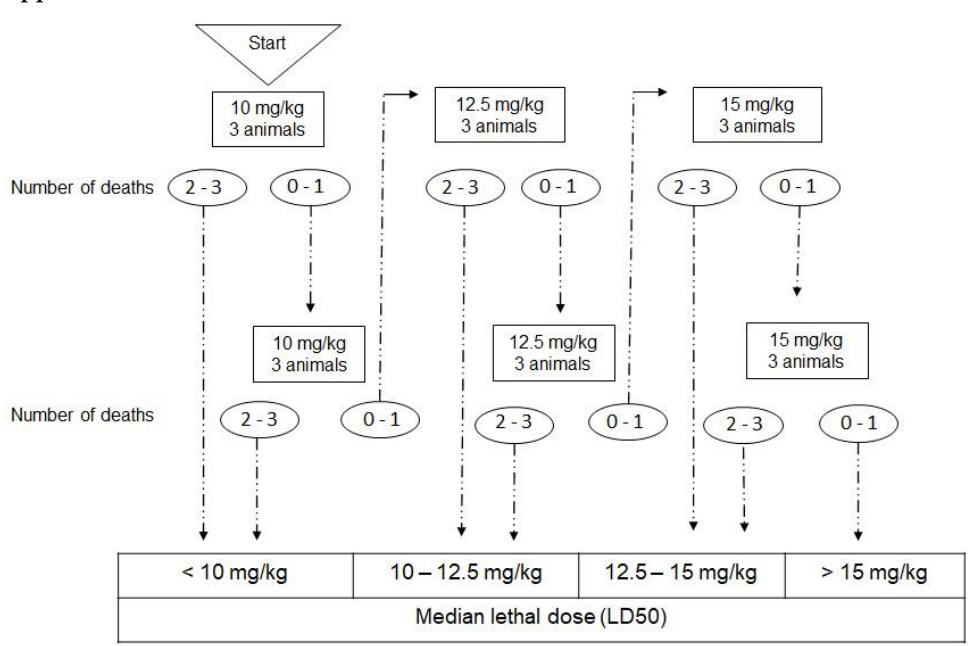
Figure A1. Treatment scheme used to assess the median lethal dose (LD50) after treatment with free DOX.